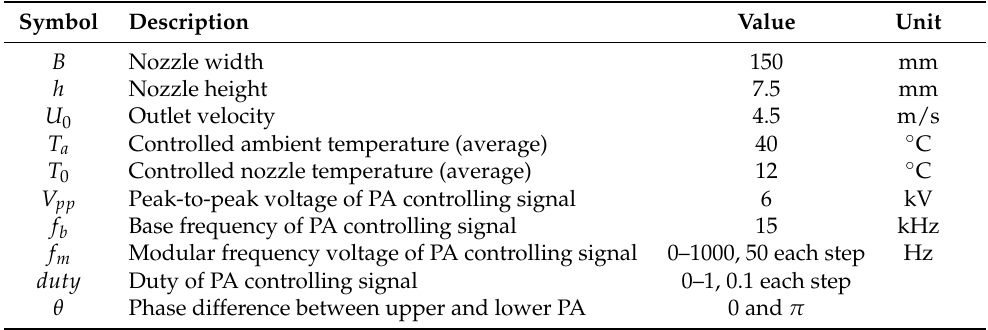
Table 1. Details of velocity and temperature experiment conditions for testing the effect of plasma actuators on the rectangular